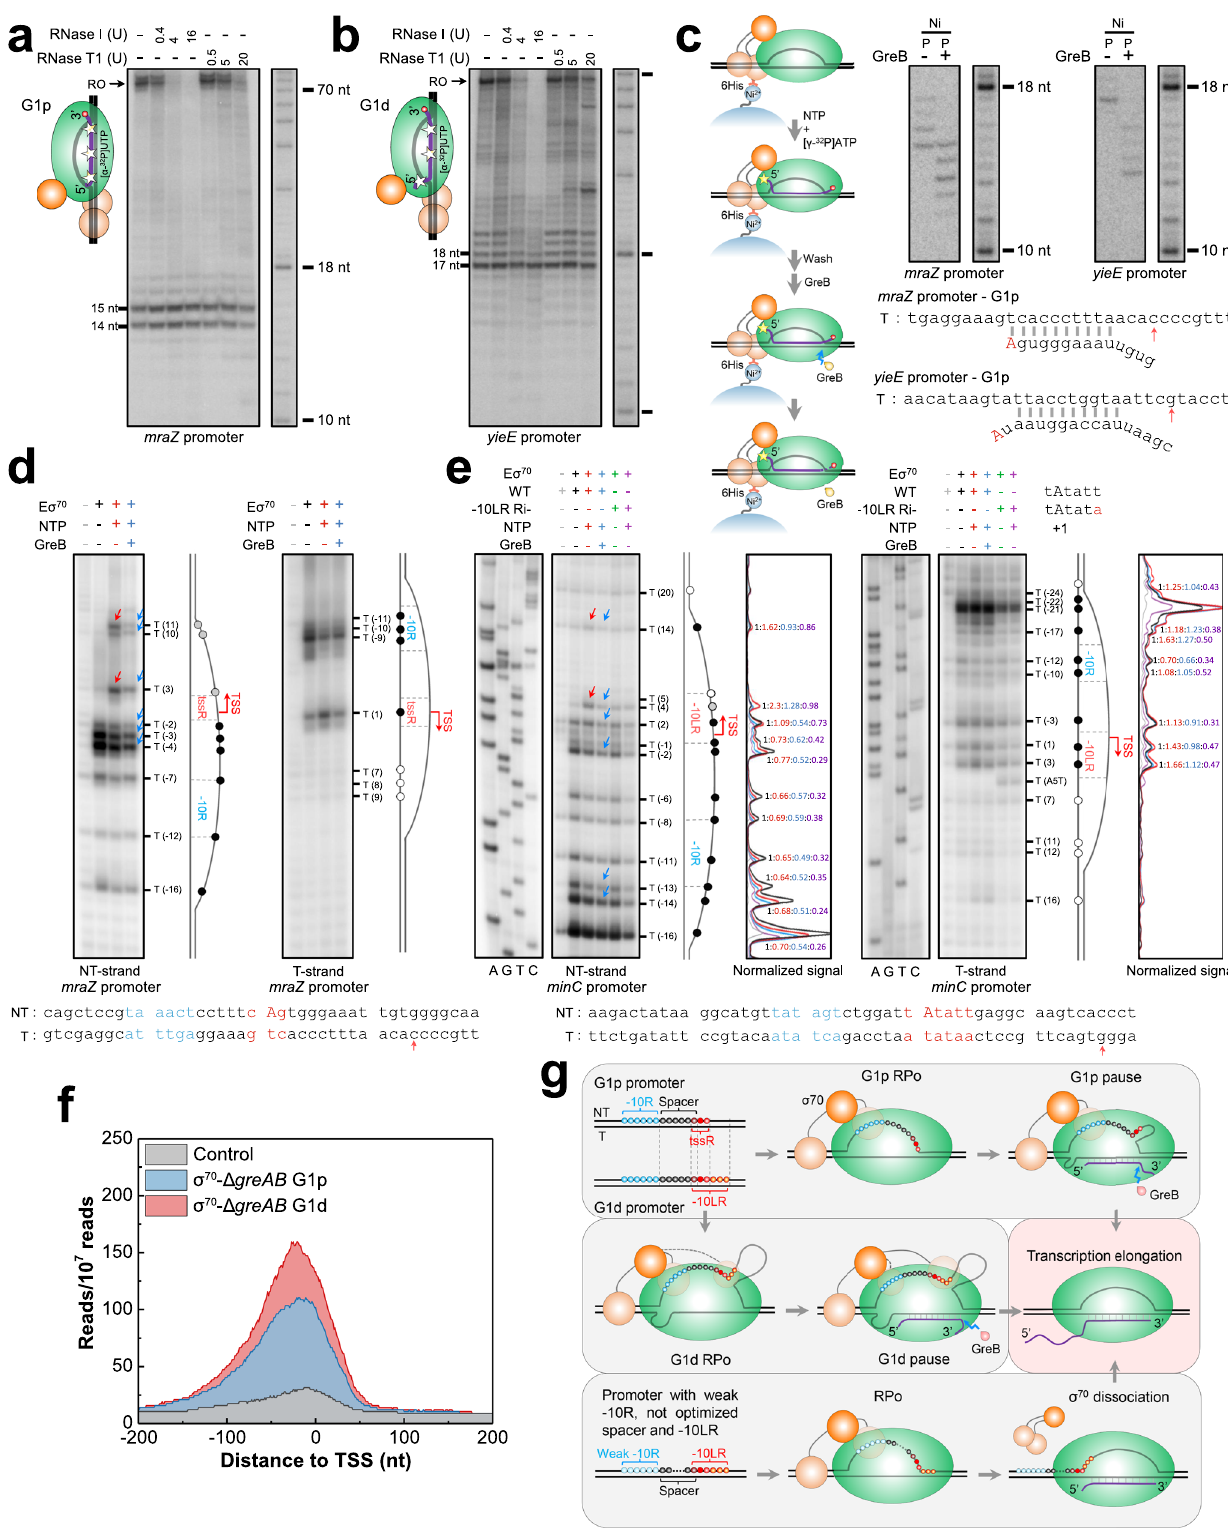
the high sensitivity of these complexes to GreB-induced transcript cleavage (Fig. 3g, h), indicated the presence of backtracked pauses at both G1 pause sites. Treatment with GreB generated cleavage products shortened by 4 – 5-nt at the 3 ′ end, con fi rming 4 − 5-bp backtracking of RNAP at the G1p and G1d pauses (Fig. 5c; Supplementary Fig. 14). As reported before, backtracking